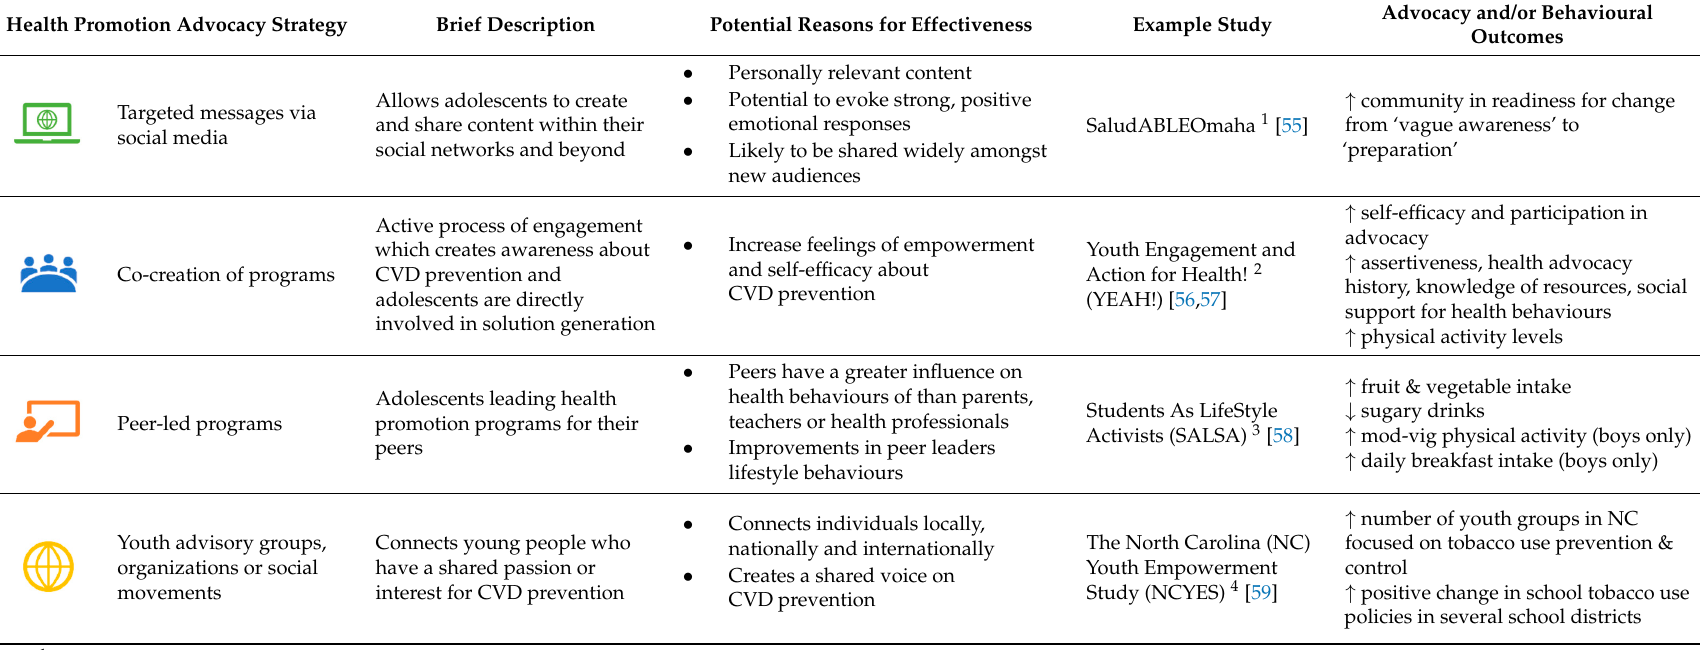
Table 2. Summary of youth advocacy strategies and examples from studies targeting one or more CVD risk factors.